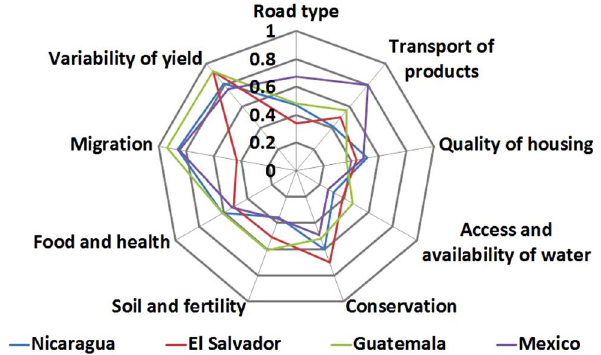
Figure 3. Sensitivity indicators in the livelihoods of small coffee producers to climate change in four countries of Mesoamerica (a high value equals high sensitivity). doi:10.1371/journal.pone.0088463.g003 PLOS ONE |